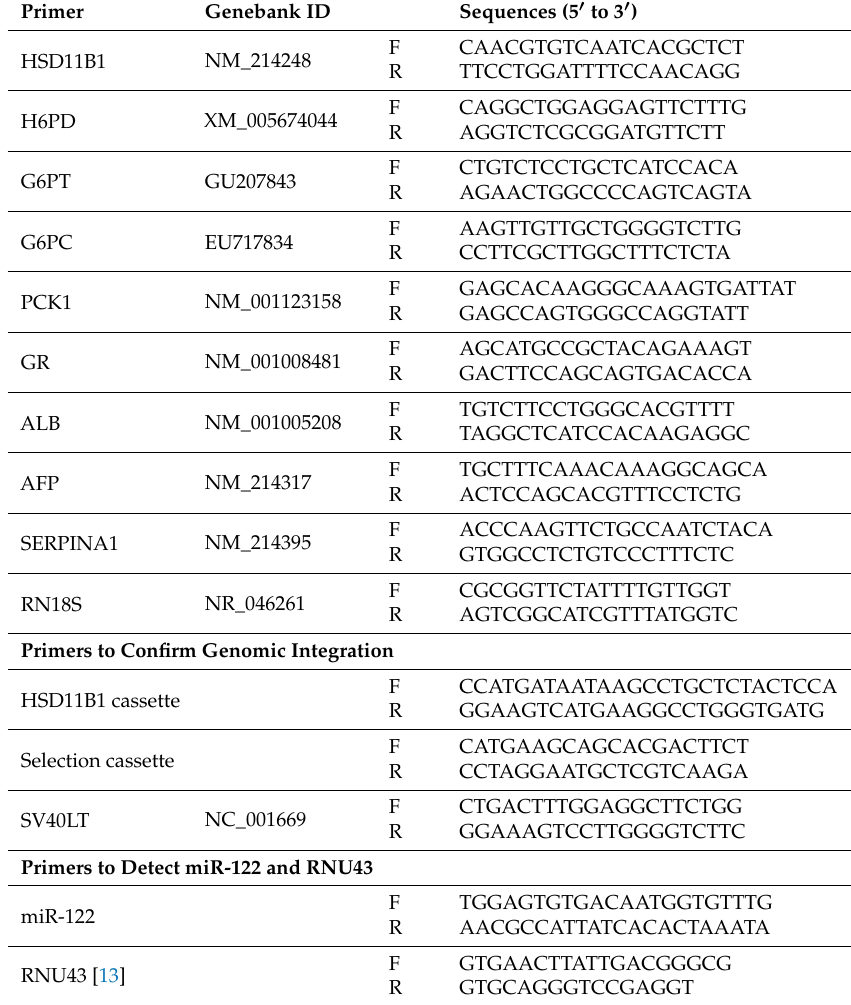
Table 1. Primer sequences used in polymerase chain reaction